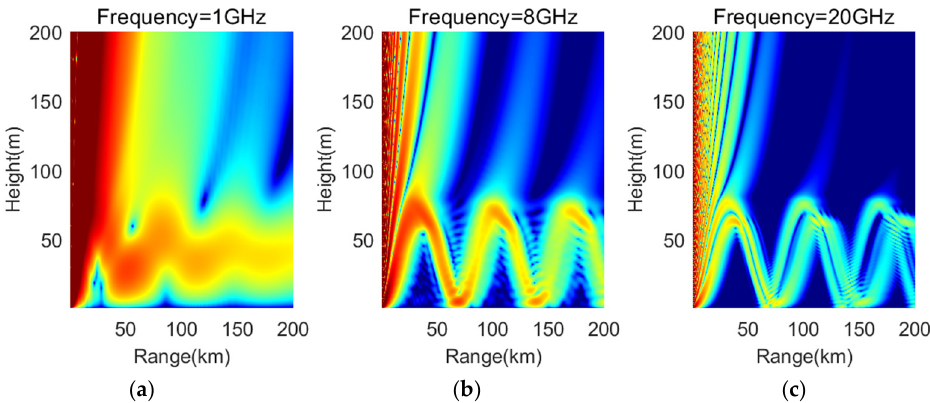
Figure 12. Path loss distributions for surface ducts with different frequencies: ( a ) frequency of 1 GHz, ( b ) frequency of 8 GHz, and ( c ) frequency of 20 GHz.